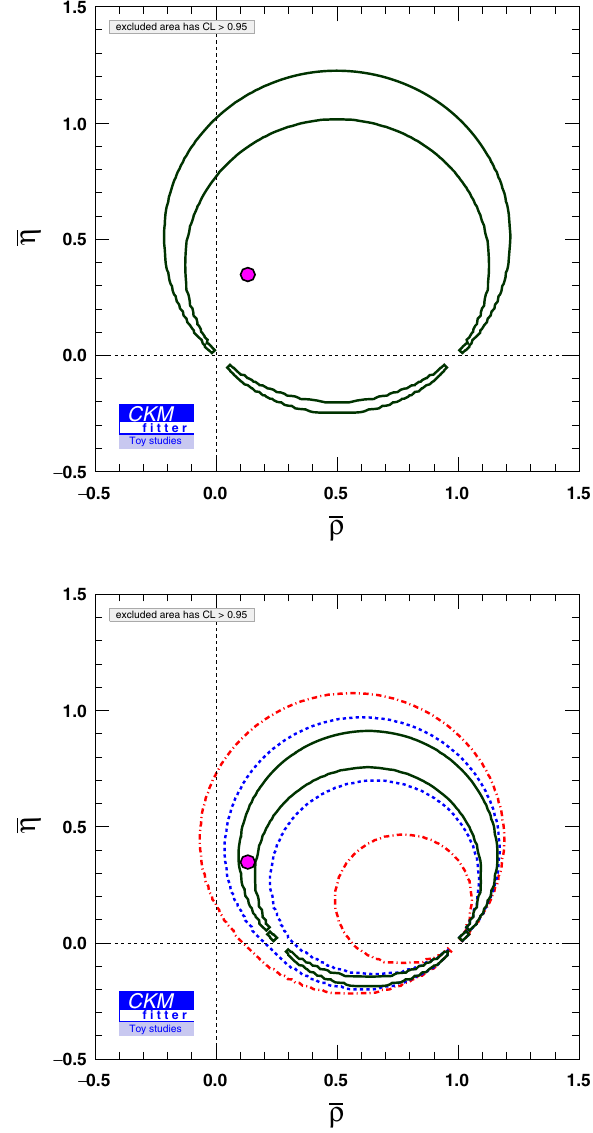
Fig. 1 Constraints in the ¯ ρ – ¯ η plane from the amplitude ratio R 0 method, using the arbitrary but realistic numerical values for the input parameters, detailed in the text. In the top panel , the P EW hadronic parameter is set to zero. In the bottom panel , the P EW hadronic param- eter is set to its true generation value with different theoretical errors on R and r V P parameters[definedinEq.(27)],eitherzero( greensolid-line contour ), 10 and 5% ( blue dashed-line contour ), and 10 and 30% ( red solid-dashed-line contour ). The parameters ¯ ρ and ¯ η are fixed to their current values from the global CKM fit [6–8], indicated by the magenta